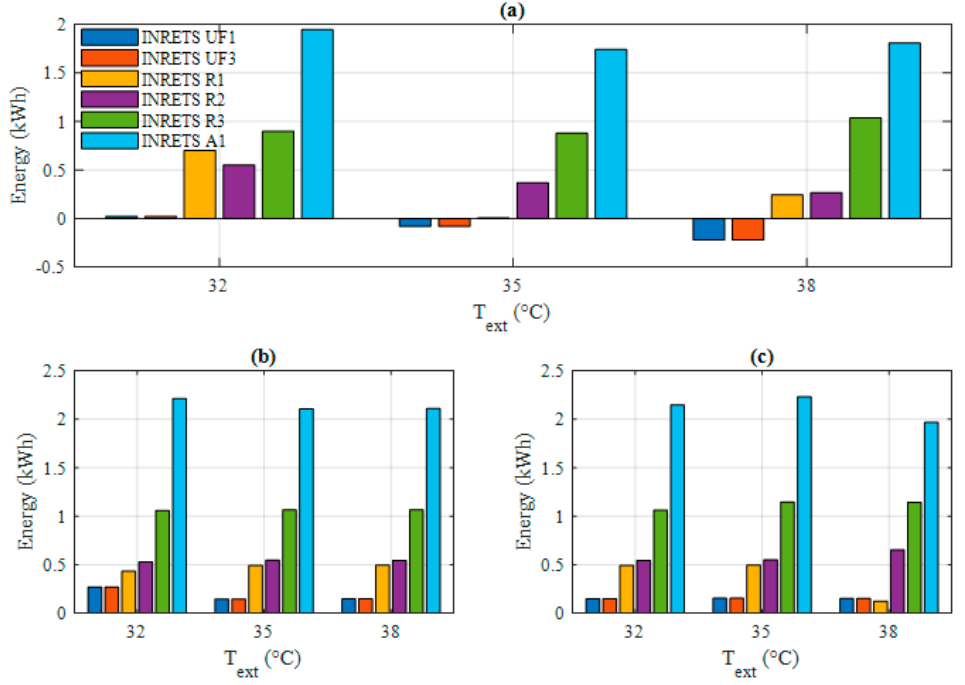
Figure 19 . Energy gain at (cid:1863) = 0.9 for a driver dressed in an informal way, for different INRETS cycle, for (cid:1844)(cid:1834) (cid:1857)(cid:1876)(cid:1872) = 55% , and for: ( a ) (cid:1869) (cid:4662) ext = 55%, and for: ( a )